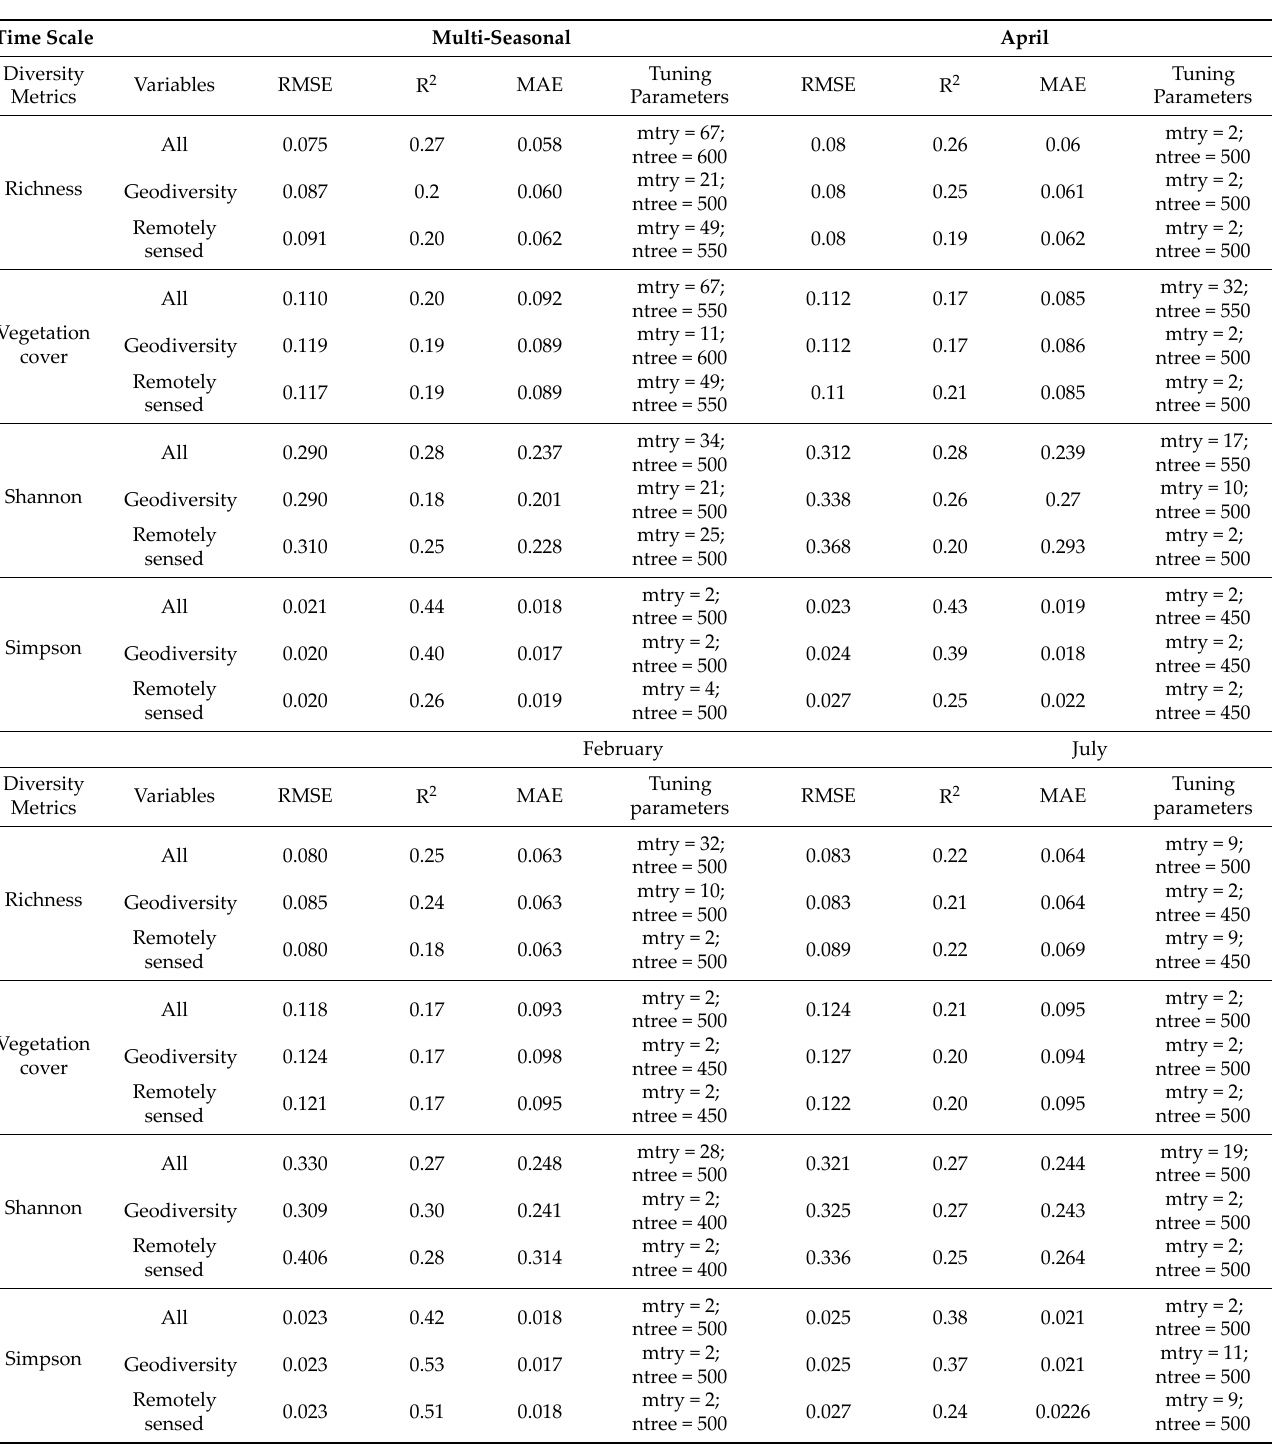
Table 3. Accuracy assessment results of single‑date and multi‑seasonal RF models based on each of the geodiversity‑ or remotely sensed‑only variables and their hyperparameter